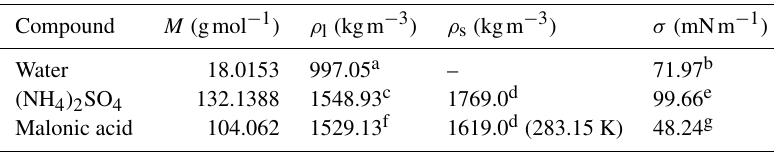
Table 2. The molar masses ( M ), liquid and solid densities ( ρ l and ρ s ) and surface tensions ( σ ) of the different droplet components at 298.15K, unless stated